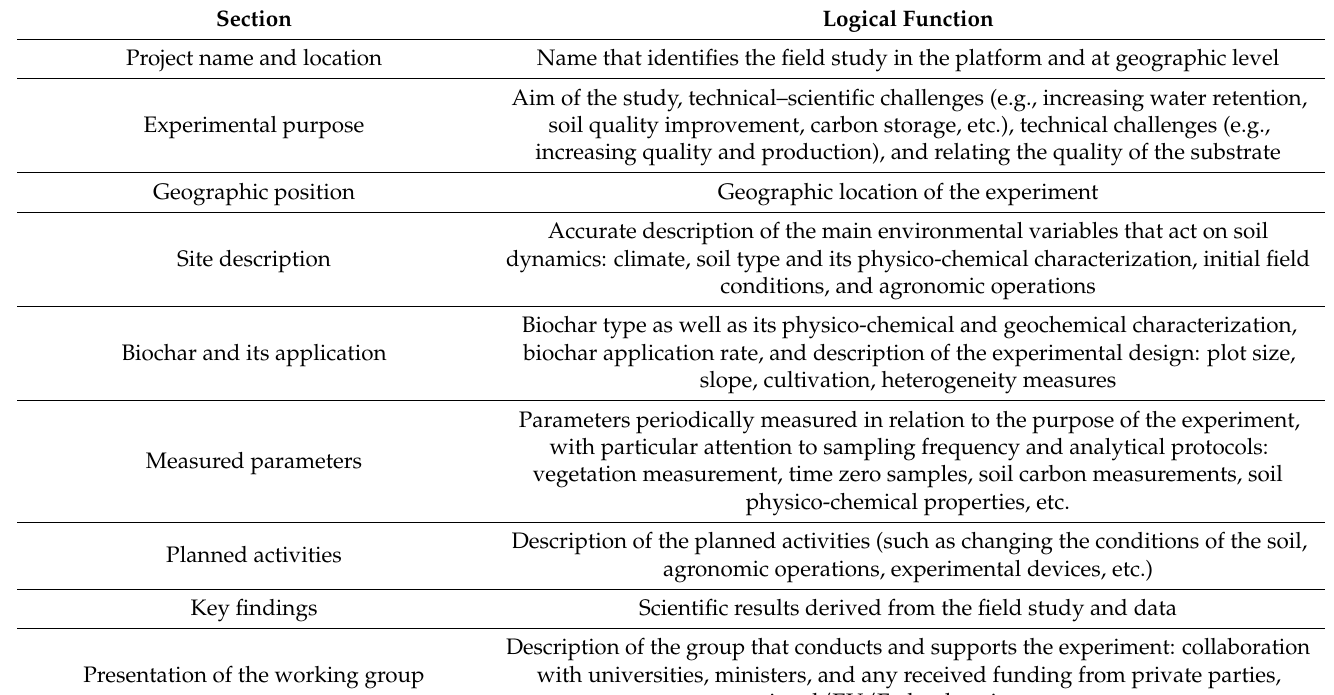
Table 4. Summary of LTEP-BIOCHAR standard